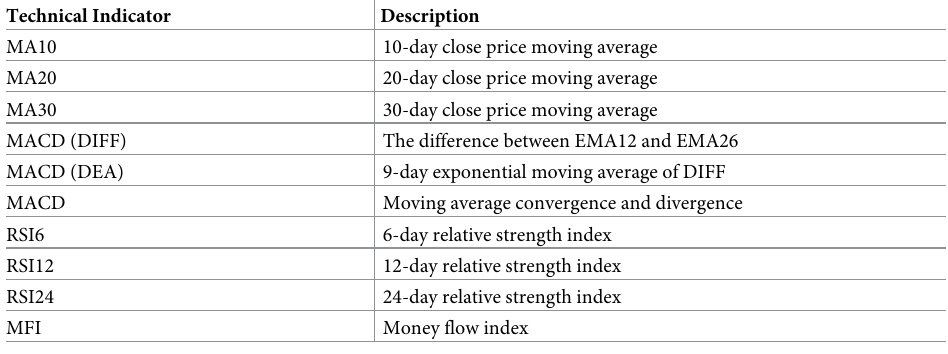
Table 3. Technical indicators selected for stock trend prediction (Adopted from